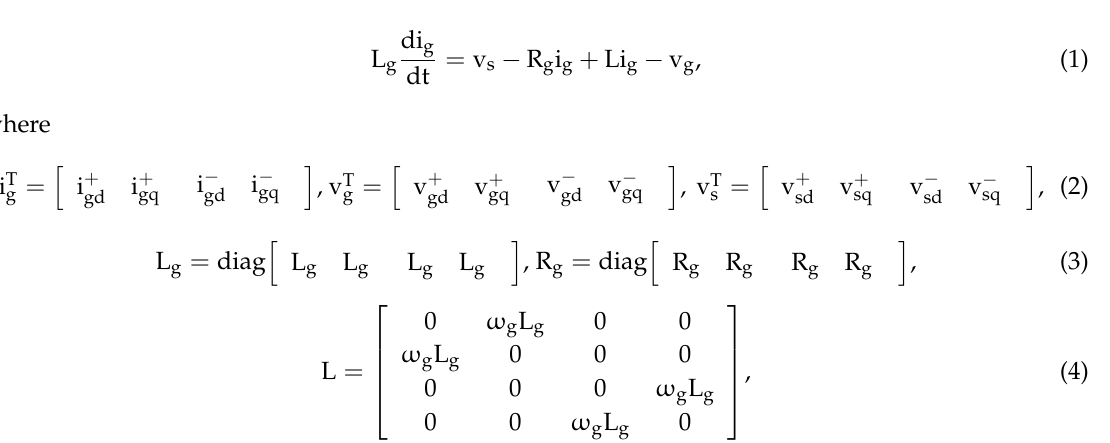
Figure 2. Orthogonal (dq)+ and (dq)− frames of references.